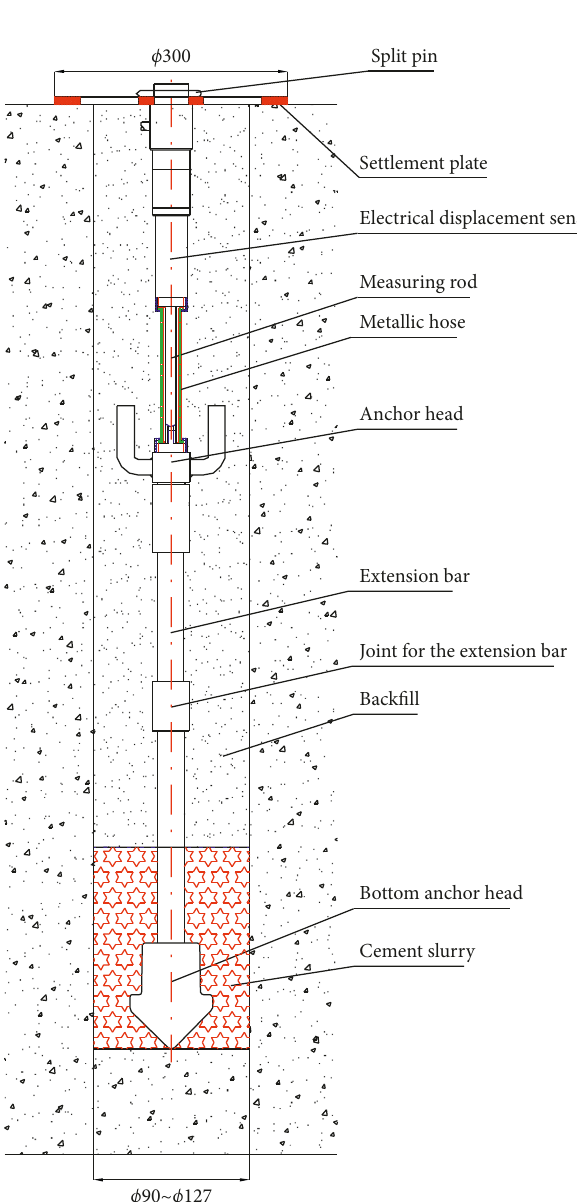
Figure 3: Schematic diagram of the single-point settlement